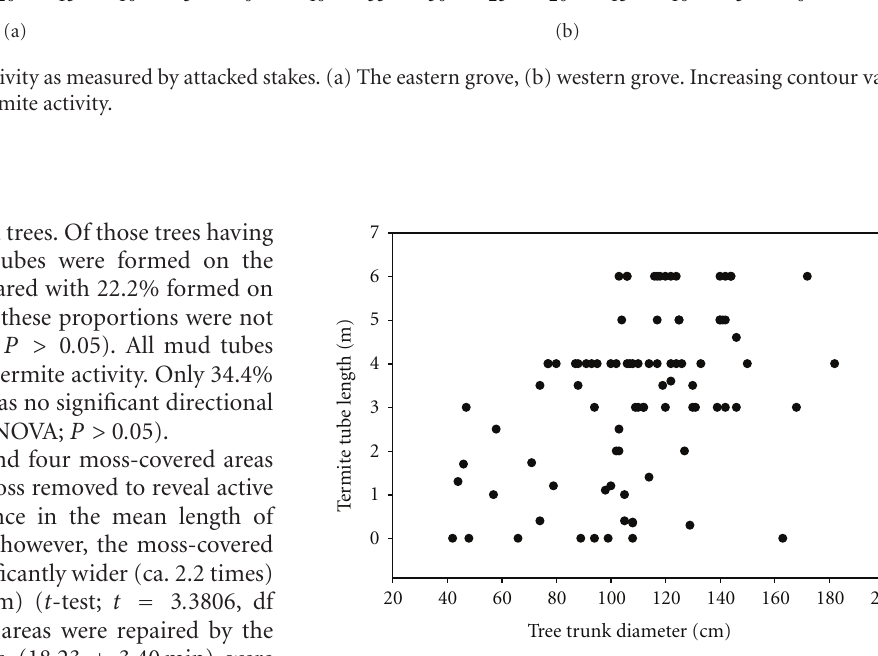
Figure 4: Relationship between tree trunk diameter measured 1.5 m above the ground and maximum termite tube length on the tree